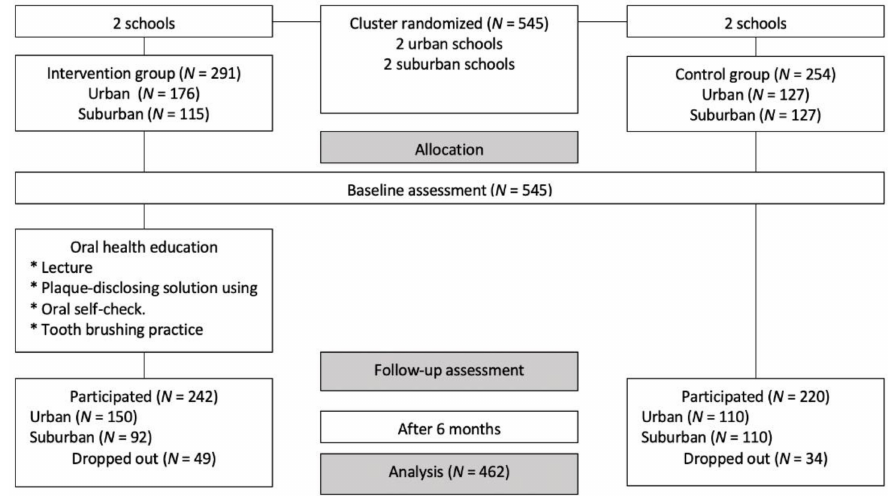
Figure 1. Study flowchart. Table 1. Socio-demographic characteristics of